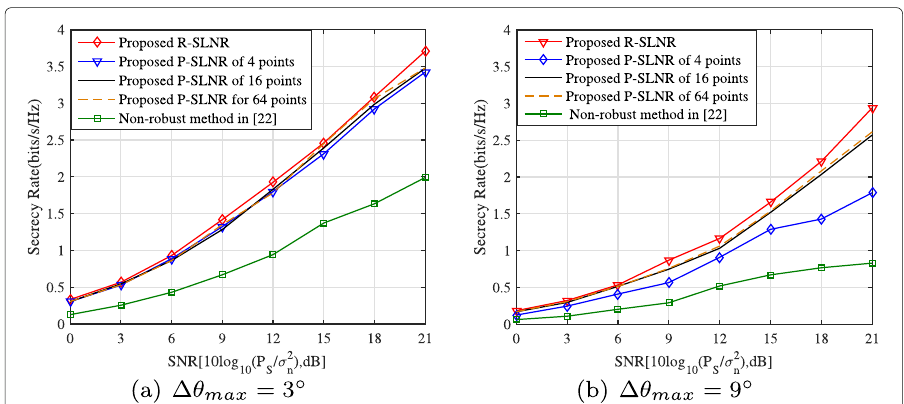
Fig. 8 Curves of secrecy rate versus SNR(10 log 10 ( P /σ 2 n ) ) of the proposed methods with (cid:7)θ max = 3 ◦ and